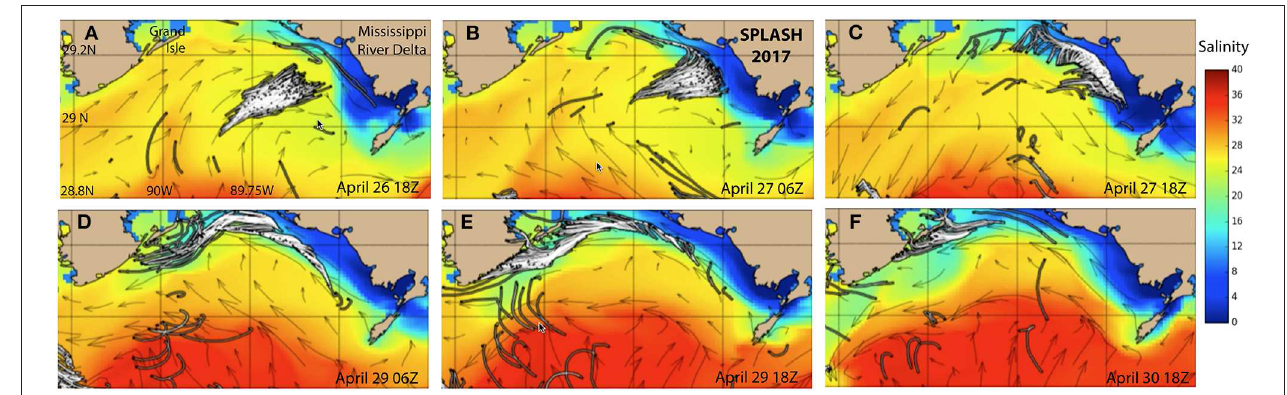
FIGURE 10 | Motion of drifters (white lines) 26–30 April in the Louisiana Bight overlaid on velocity vectors and surface salinity from the NCOM 1 km real-time model. Drifter “tails” are 12 h long. (A) April 26 18Z. (B) April 27 06Z. (C) April 27 18Z. (D) April 29 06Z. (E) April 29 18Z. (F) April 30 18Z.